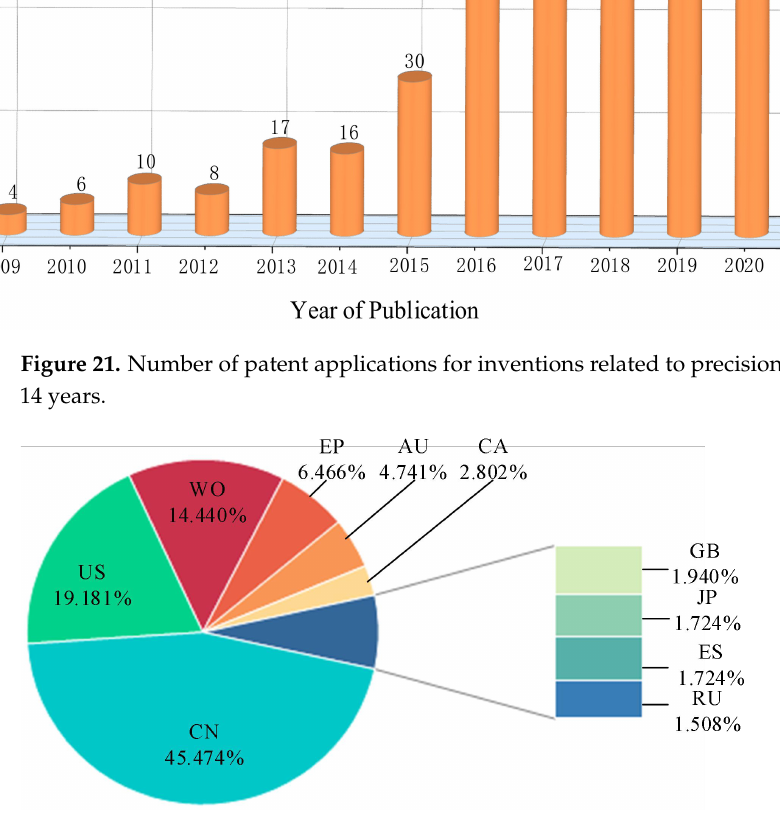
Figure 22. Contribution and influence of top 10 countries/regions in the number of patents